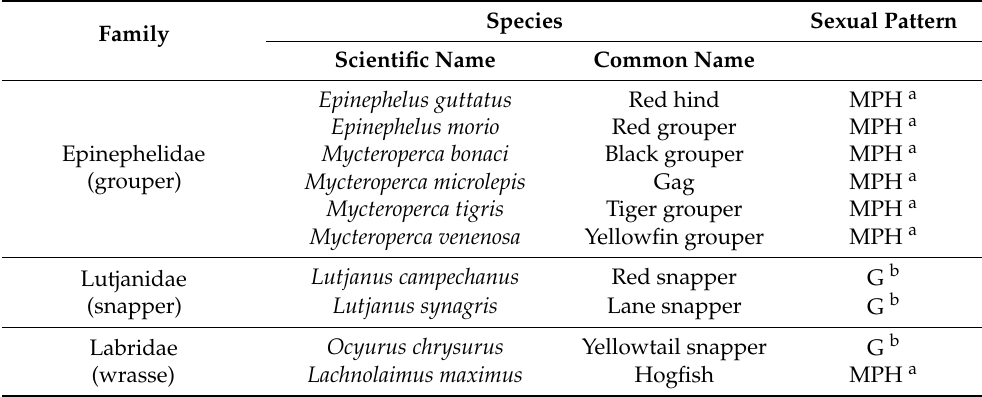
Table 1. Tropical fish species from the Campeche Bank analyzed in the present study. a : MPH = monandric protogynous hermaphroditism; b : G = gonochorism